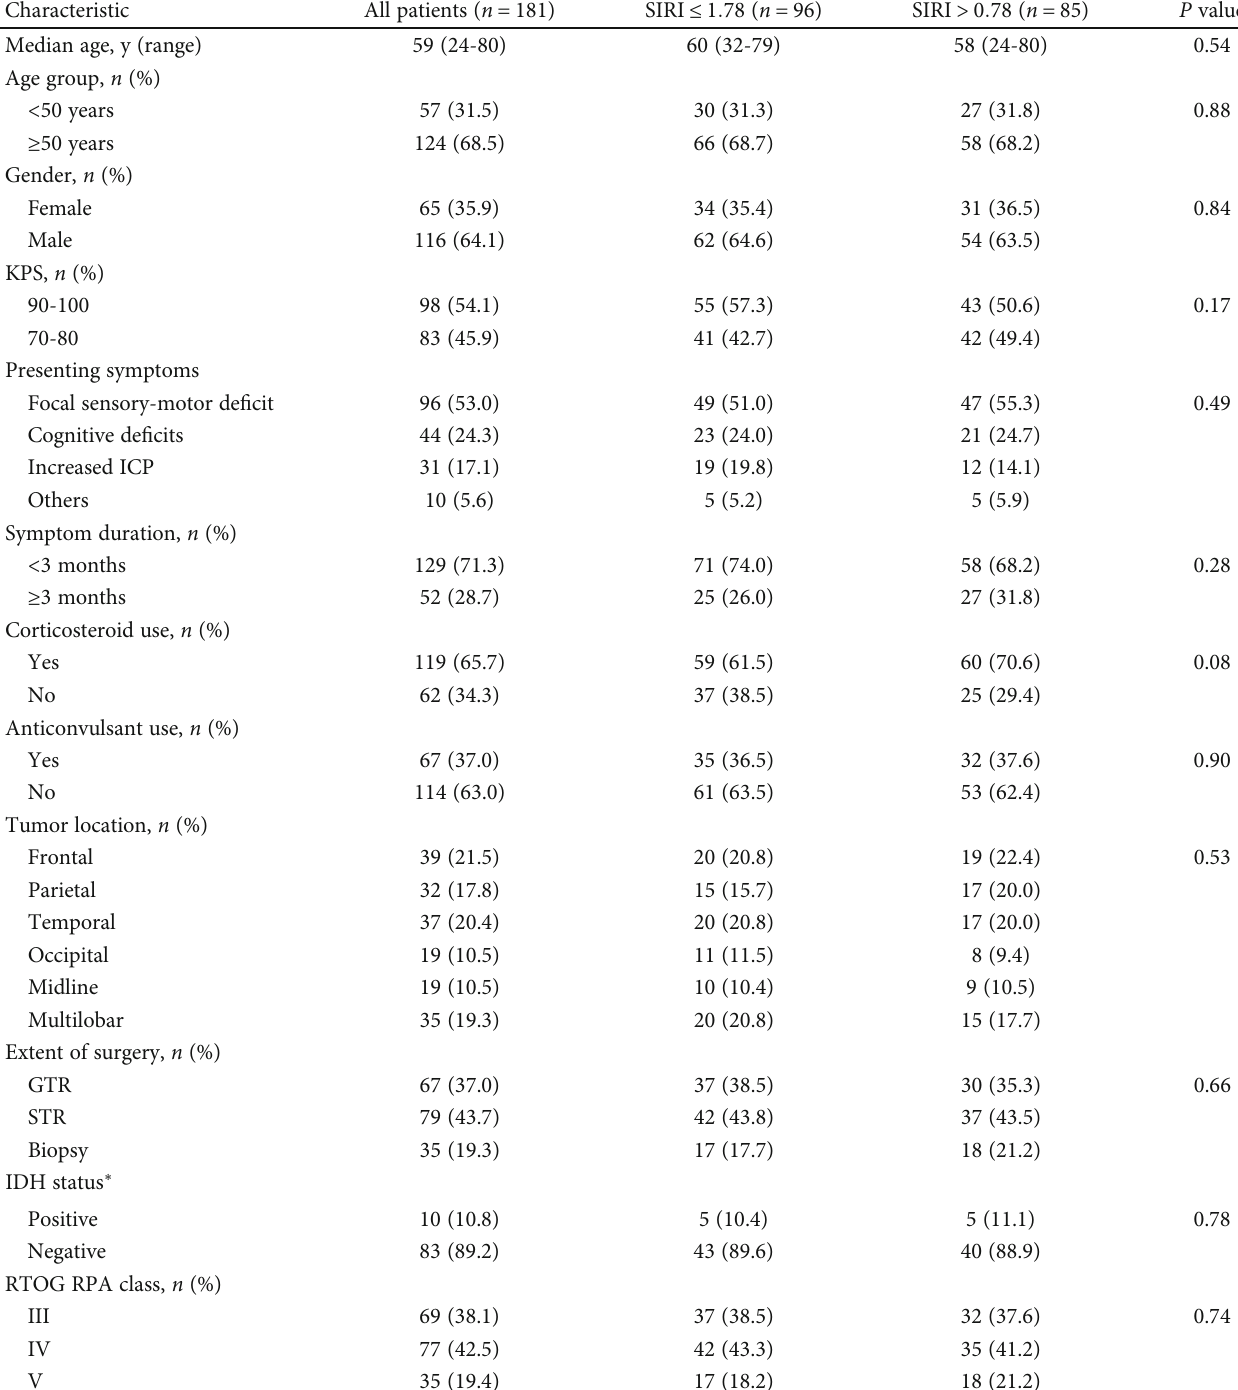
Table 1: Baseline demographics per SIRI